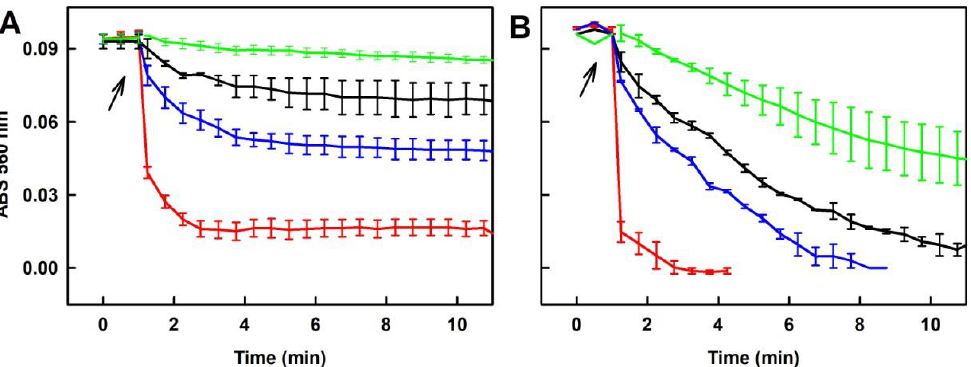
Figure 3. Time-dependent reduction of the • cPTIO radical by Na 2 S 2 and Na 2 S 4 . Reduction of the • cPTIO radical was detected as decrease of ABS at 560 nm minus ABS at 730 nm (ABS 560 nm). Arrow indicates addition of 100 µ M • cPTIO to 100 µ M Na 2 S 2 ( A ) or 100 µ M Na 2 S 4 ( B ) incubated 15 s (red), 20 min (blue), 40 min (black) and 70 min (green) in the buffer consisting of 100 mM sodium phosphate and 100 µ M DTPA pH 7.4, at 37 ◦ C. Means ± SE; n = 3.